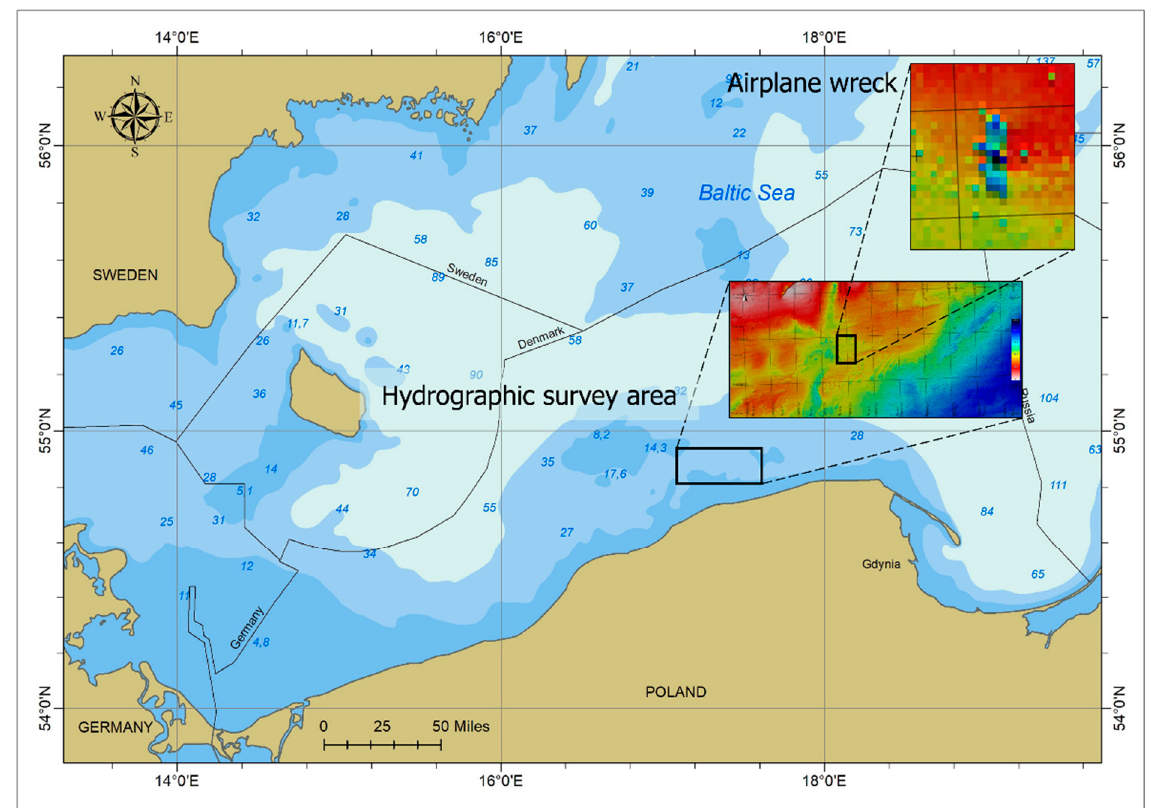
Figure 1. Location of study area where the survey was conducted by Arctowski.